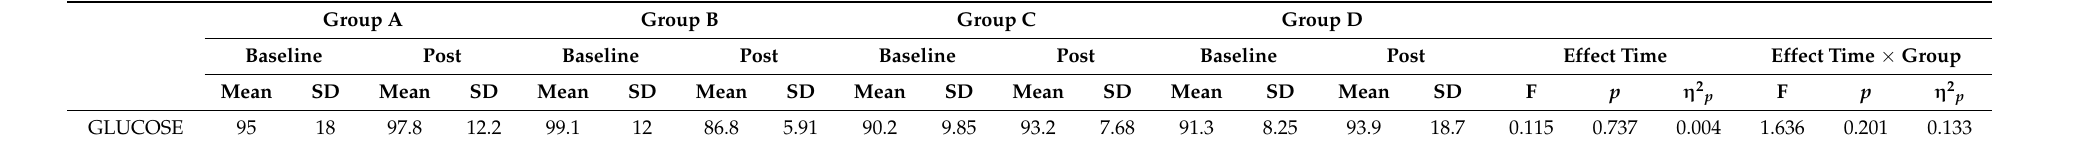
Table 2. Effect on plasma glucose before and after